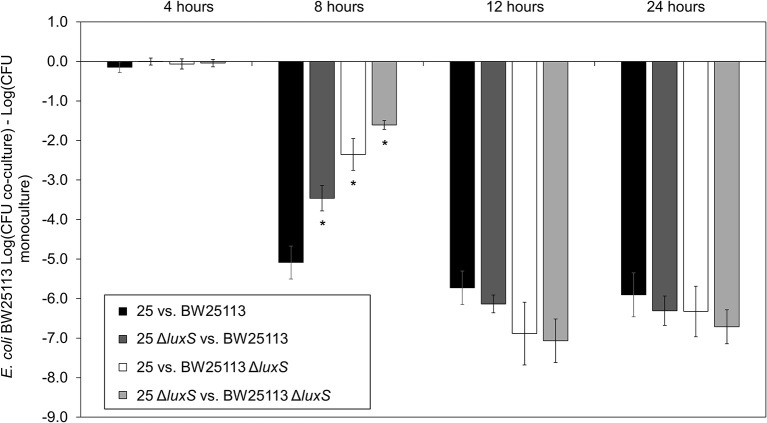
Delayed mccPDI inhibition when luxS is deleted. Competition assays between mccPDI-positive E. coli strain (25 or 25 ΔluxS) and target E. coli strain (BW25113 or BW25113 ΔluxS) in M9 media for 4, 8, 12, and 24 h. Results are expressed as the difference of mean log CFU during co-culture and mono-culture of the target strain (n = 3 independent replicates; error bar = SEM). *P < 0.05 compared to wild-type co-culture (black bars) based on two-way ANOVA.